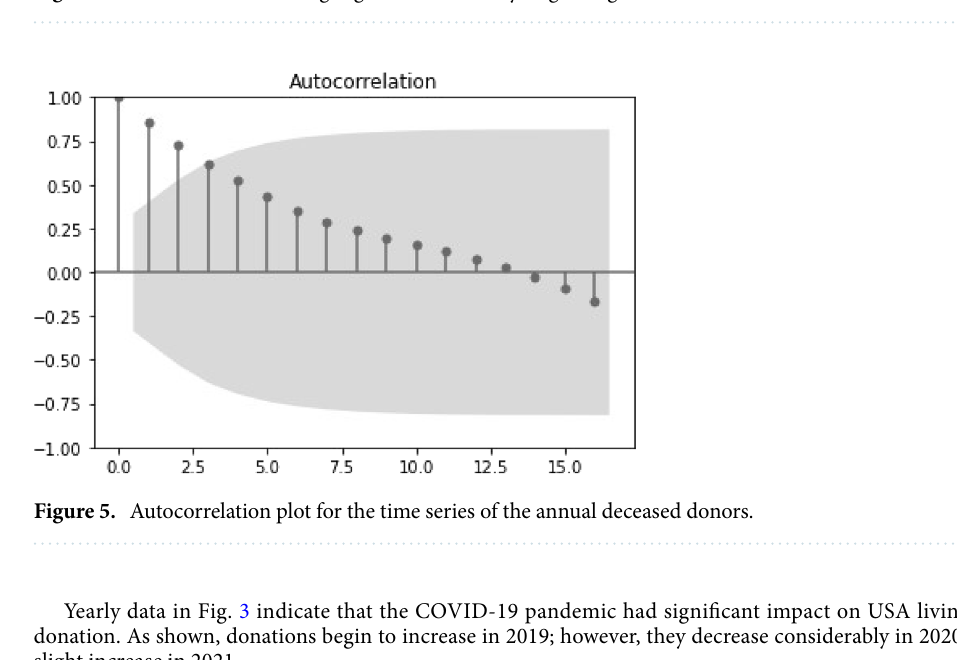
Figure 4. Number of USA living organ donors weekly, beginning of 2019 until week 3 in 2022.